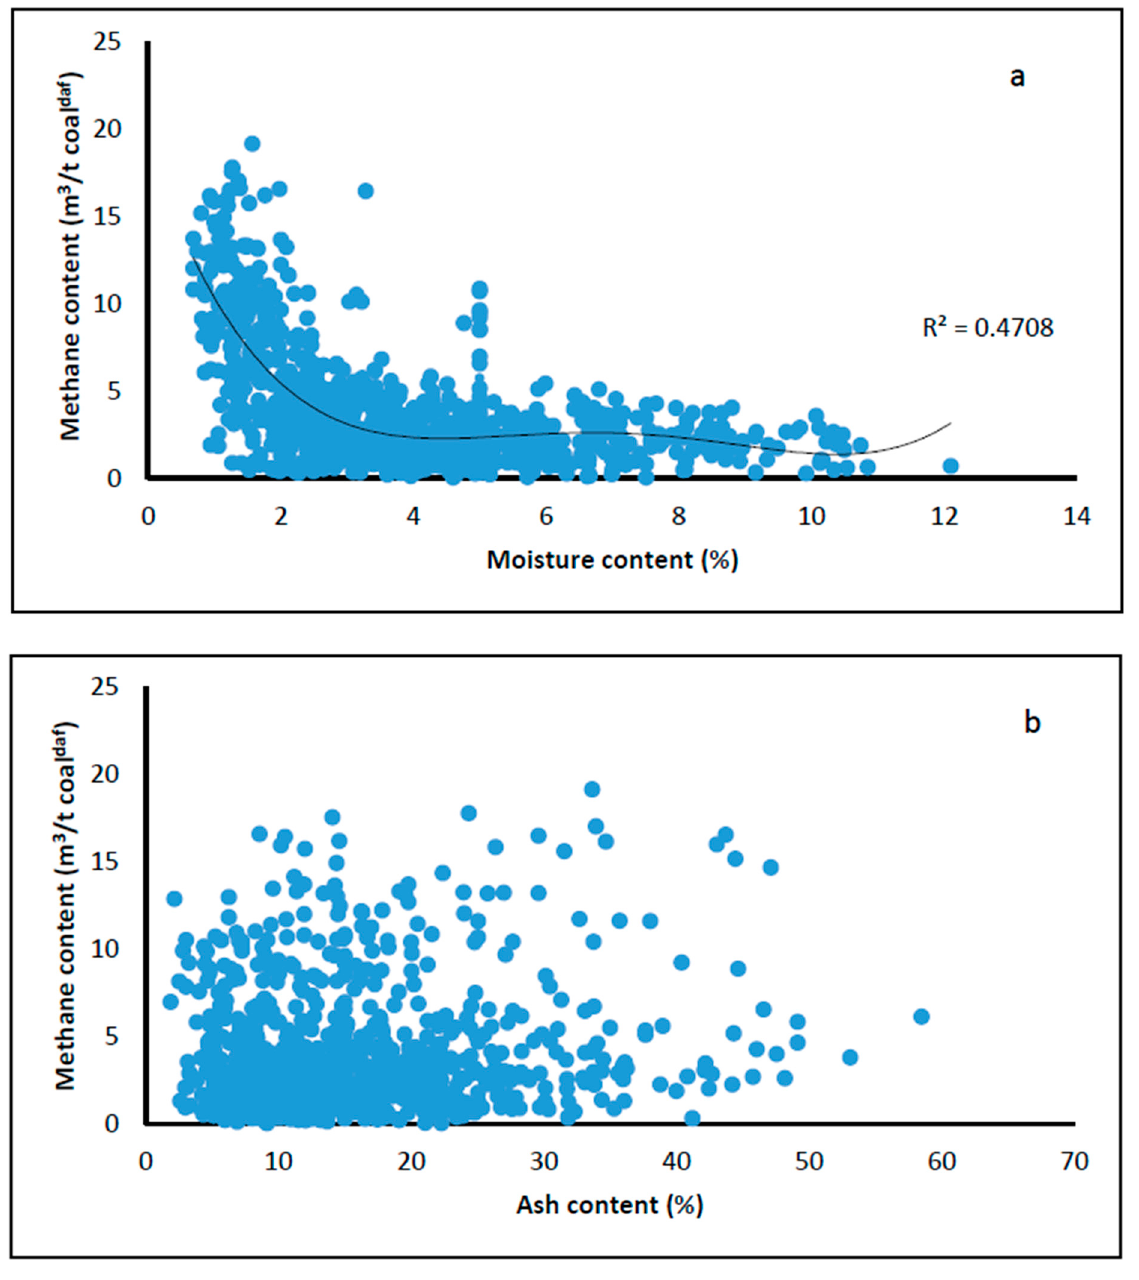
Figure 12. Methane content vs. moisture content ( a ) and ash content ( b ).